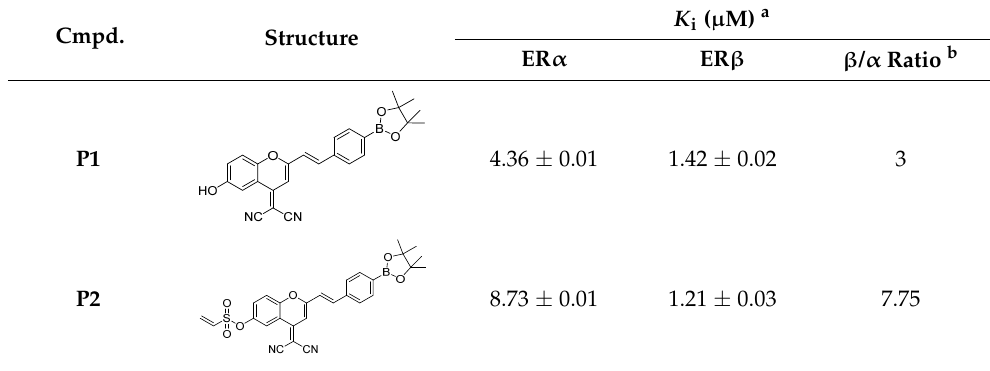
Table 2. The K i values of P1 – P2 for ER α and ER β . Cmpd.